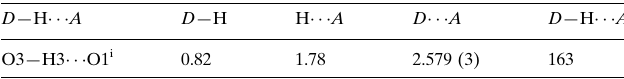
Hydrogen-bond geometry (A˚ , (cid:2)